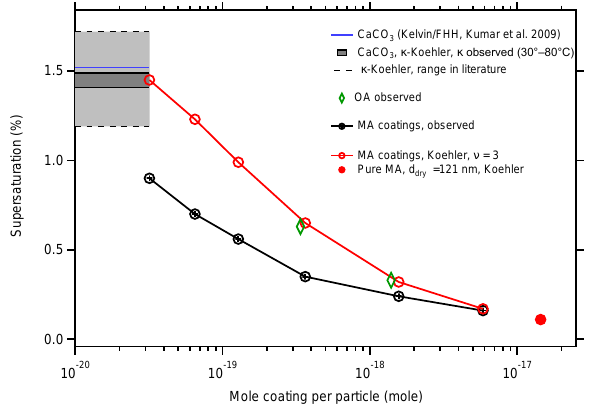
Figure 7. Comparison of SS crit predicted by Koehler theory with observations. Koehler theory for aqueous MA solutions assuming full dissociation ( ν = 3) overpredicts SS crit (red circles) compared to the observation (black circles). With increasing coating amount Koehler theory approaches the observation, with the limiting SS crit for 121.0nm particles made of pure malonic acid. For compari- son we also show observed SS crit for the two thickest OA coatings (green diamonds). The horizontal lines indicate SS crit of the bare CaCO 3 particles as calculated from our observed κ (black) and pre- dicted by Kelvin–FHH theory (blue). Light grey area between the thin dashed grey lines shows the range of SS crit for 101.9nm par- ticles calculated from the range of κ in literature for wet-generated CaCO 3 particles (compare Tang et al.,